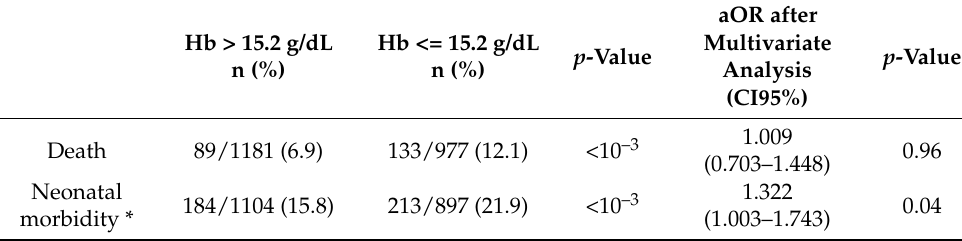
Table 2. Perinatal outcome comparisons at birth depending on the Hb threshold (15.2 g/dL).